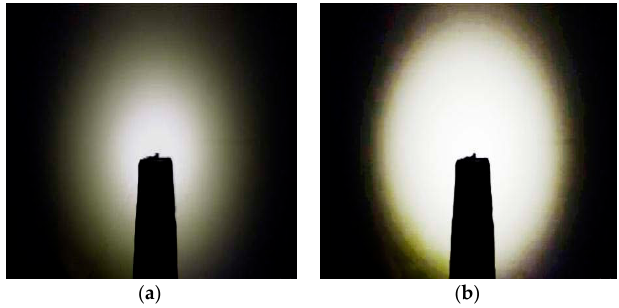
Figure 4. Flare contrast for ordinary light and the light in this design. ( a ) Conventional